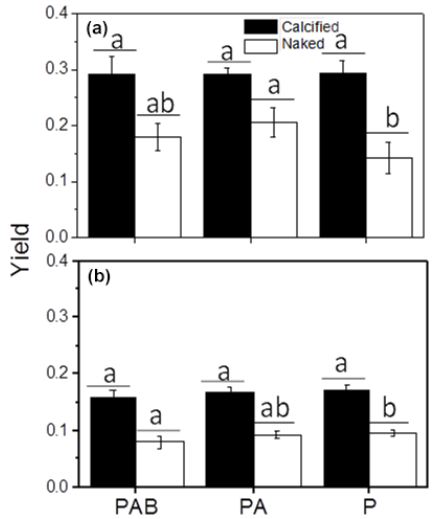
Figure 6. The change in quantum yield of the calcified and naked cells of E. huxleyi when transferred from indoor to outdoor con- ditions, being exposed to PAR alone ( P ), PAR + UV-A (PA) and PAR + UV-A + UV-B (PAB) for 60min at around noontime. Panel (a) : measured on a cloudy day (average PAR, UV-A and UV-B were 481µmolphotonsm − 2 s − 1 , 22.1 and 0.7Wm − 2 , respectively); panel (b) : measured on a sunny day (average PAR, UV-A and UV- B were 1605µmolphotonsm − 2 s − 1 , 69 and 2.4Wm − 2 , respec- tively). Different letters represent significant differences among the light treatments. Different horizontal lines represent significant dif- ferences between the different